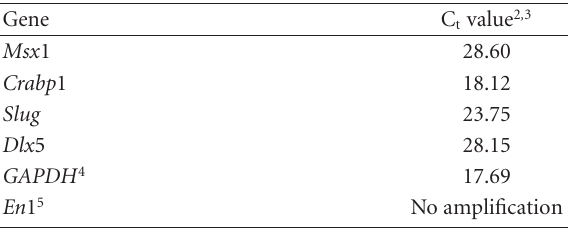
Table 1. Expression of NCC marker genes by FACS-isolated, EGFP-labeled NCC. 1